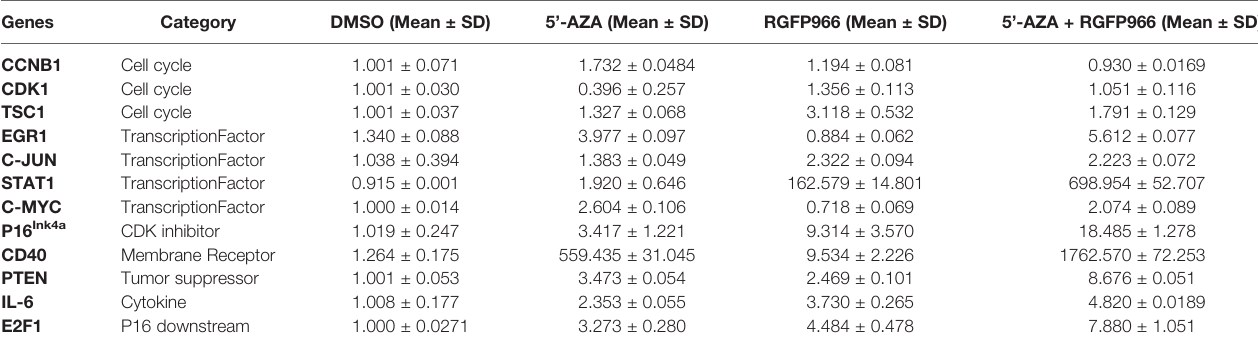
TABLE 2 | Changes in gene expression changes by 5 ’ -AZA and RGFP966 treatment.